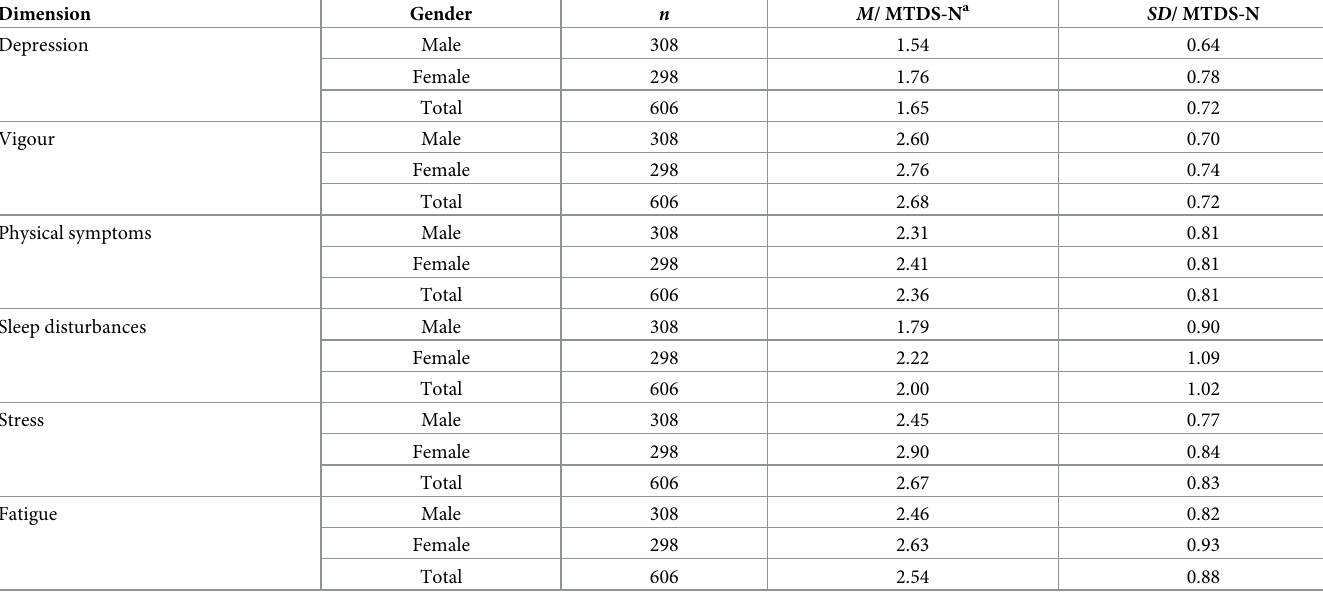
correlations were positive and significant, except for the correlation between physical symp- toms and vigour for males ( r = -0.00) and females ( r = 0.03). Based on the strength of the corre- lations between the dimensions of MTDS-N, it was determined that it was conceptually sound Table 3. Mean scores for the dimensions in the Norwegian Multicomponent Training Distress Scale.